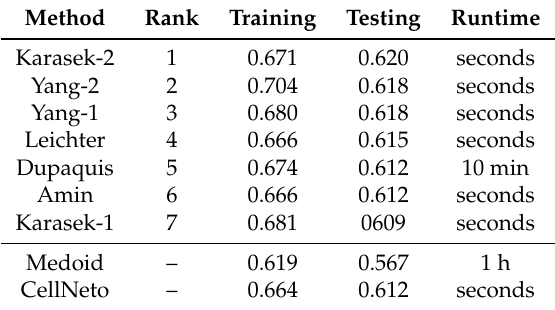
Table 1. Competition